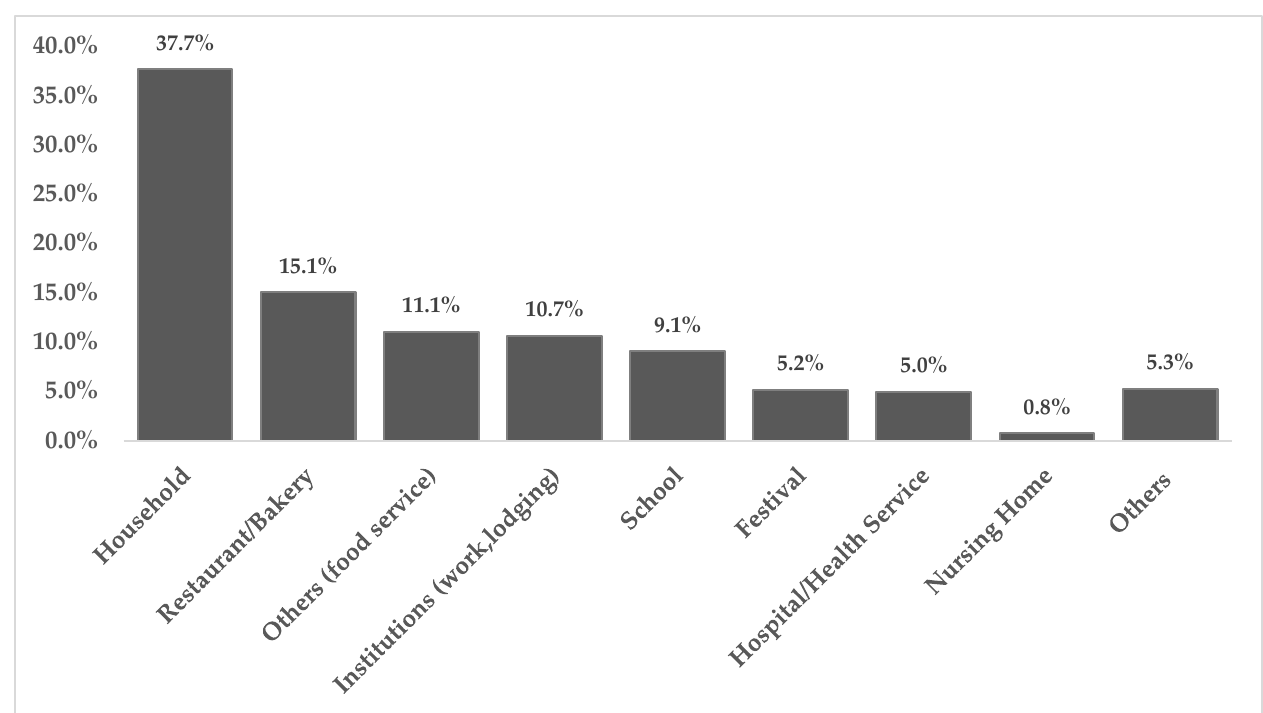
Figure 1. Numbers of FBD outbreaks in Brazil between 2012 and 2021. Adapted from [8].